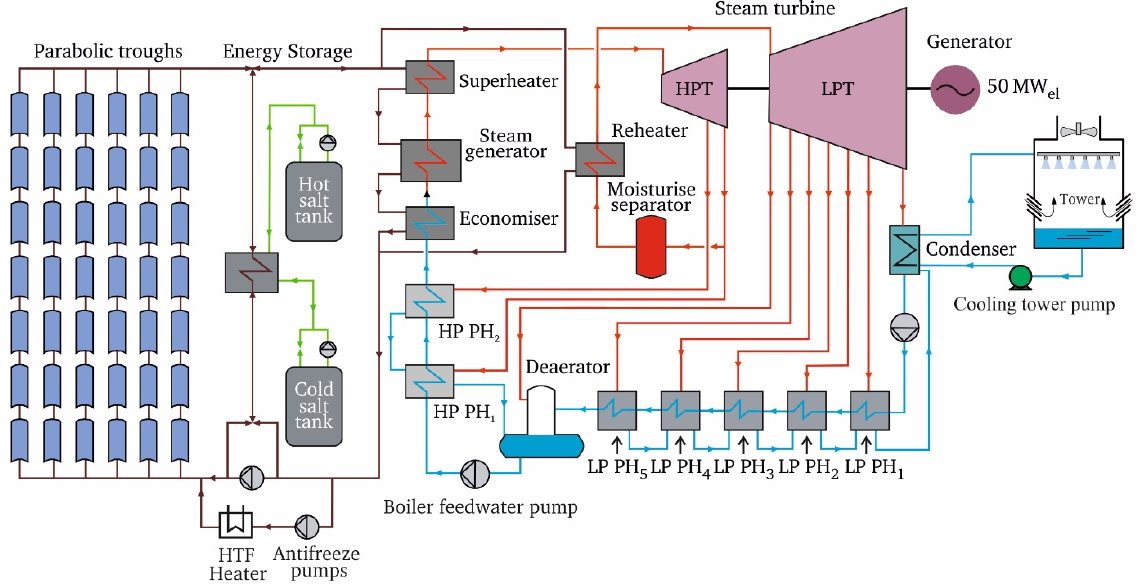
Figure 3 . Schematic flow diagram of parabolic trough solar power plant [13] . Figure 3. Schematic flow diagram of parabolic trough solar power plant [13].